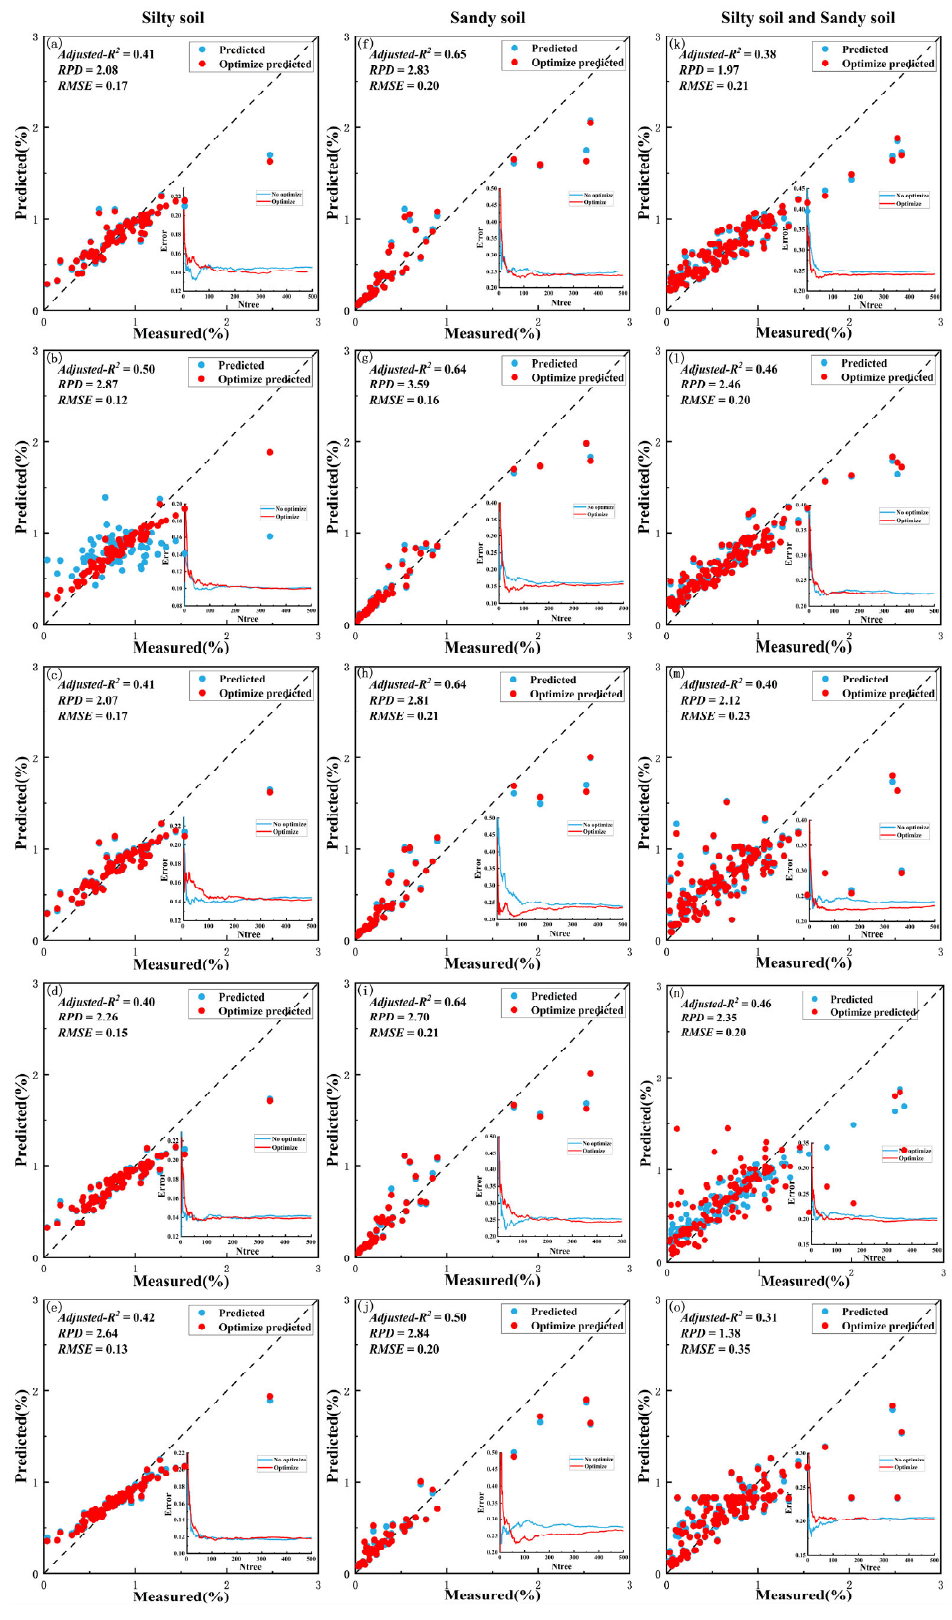
Figure 9. ORFR model results. ( a – e ) are silty soil; ( f – j ) are sandy soil; ( k – o ) are silty soil and sandy soil; the order was R, R ′ , 1/R, log(1/R), and CR.